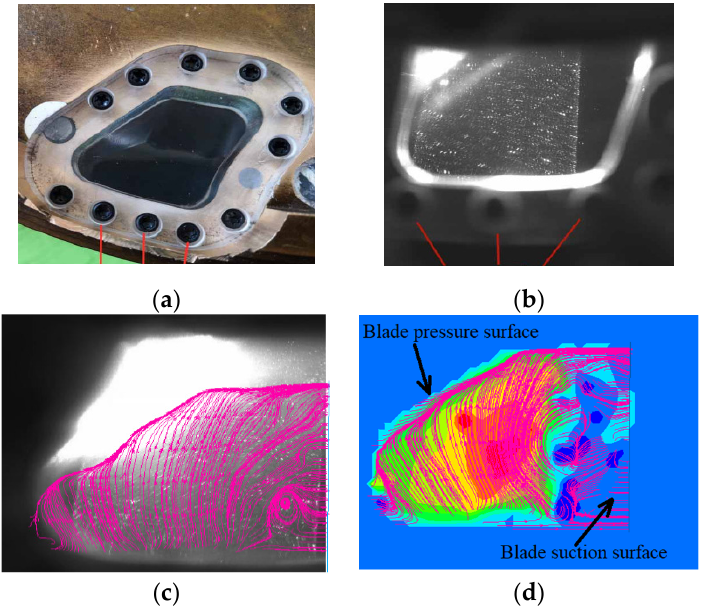
Figure 7. Test image location map: ( a ) model position (screw); ( b ) shooting position (screw); ( c ) streaming position; ( d ) schematic of processing results.